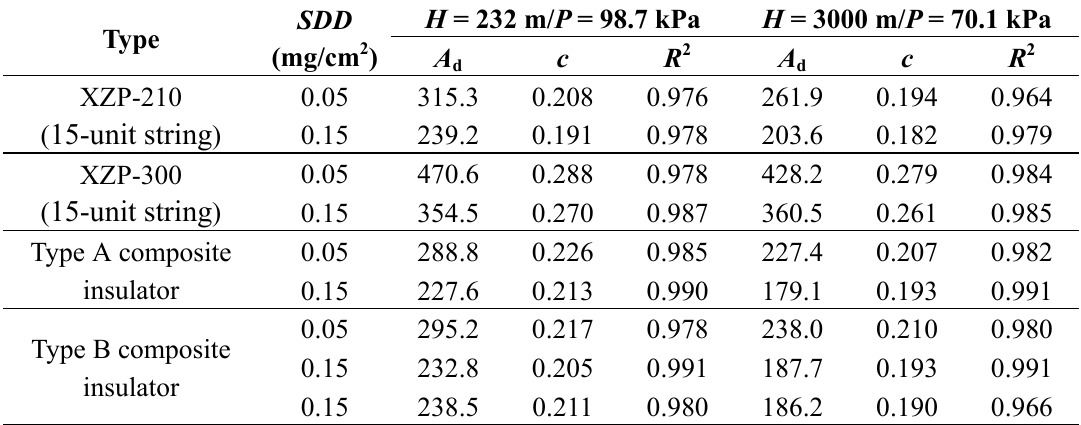
Table 4. Fitting values of A with Equation